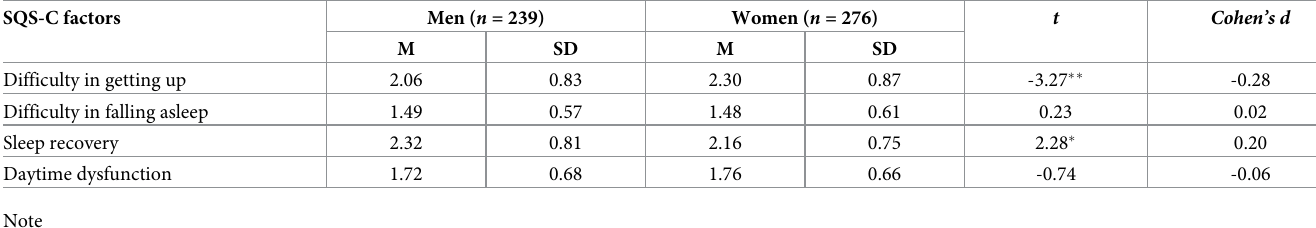
Table 3. Gender differences in the SQS-C factors ( n =